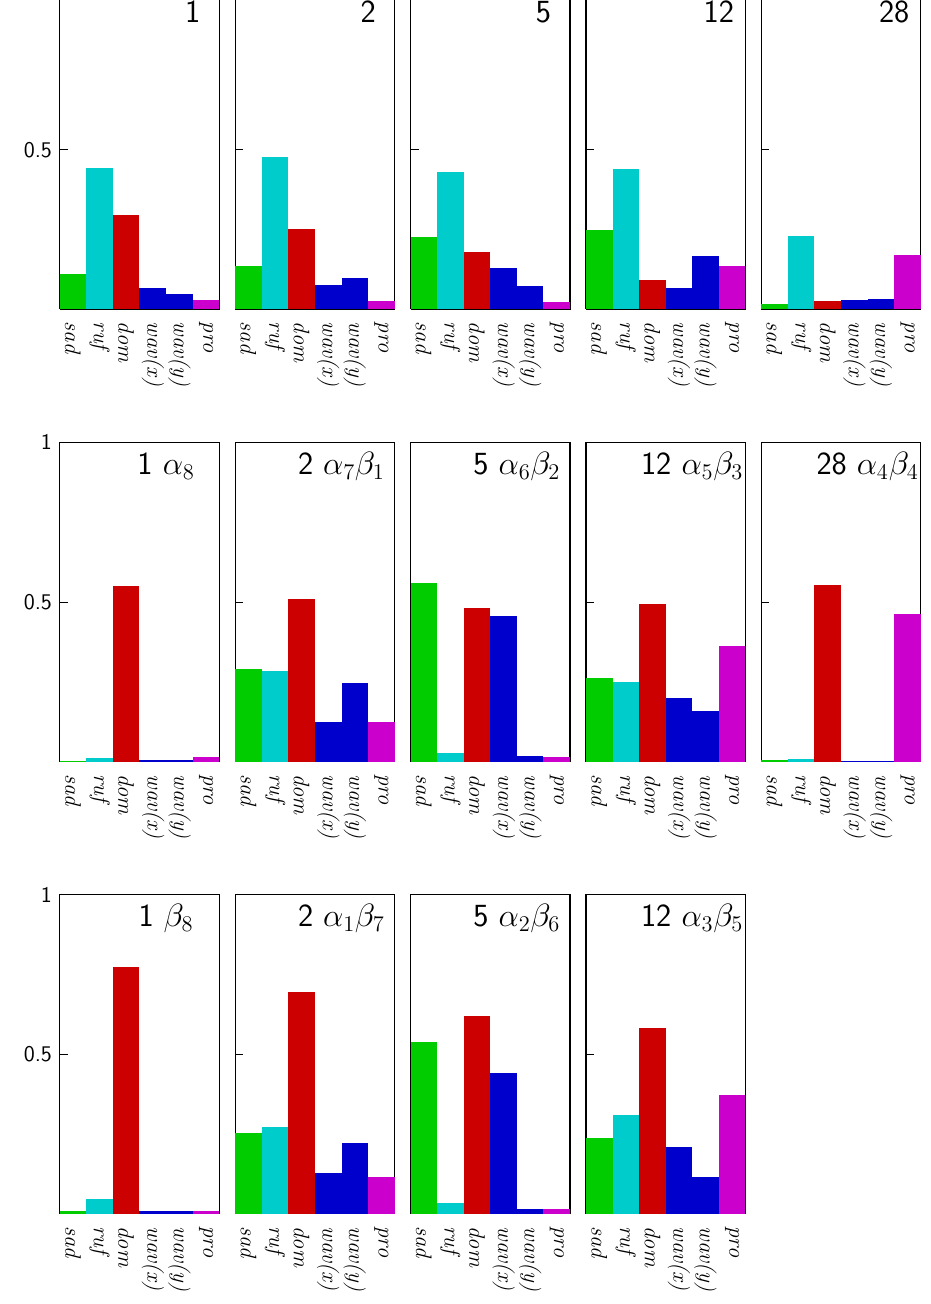
Figure 5 . NSD results for the selected Ni(OEP)—graphite structures, which were depicted in Figure 4 (middle and bottom rows), and for the corresponding isolated Ni(OEP) structures (top